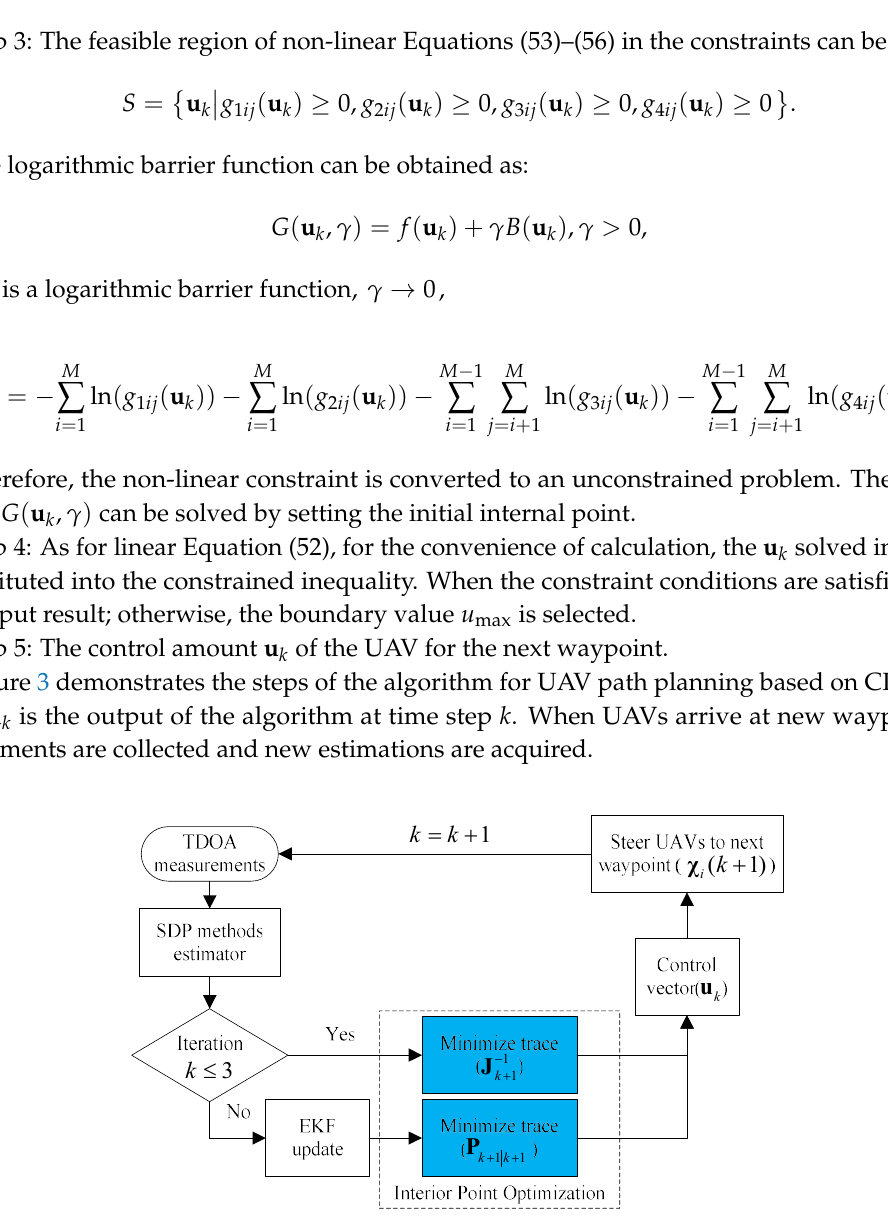
. The headings for UAVs are all equal to 2  (north) at the initial moment and other key parameters are listed in Table 1.